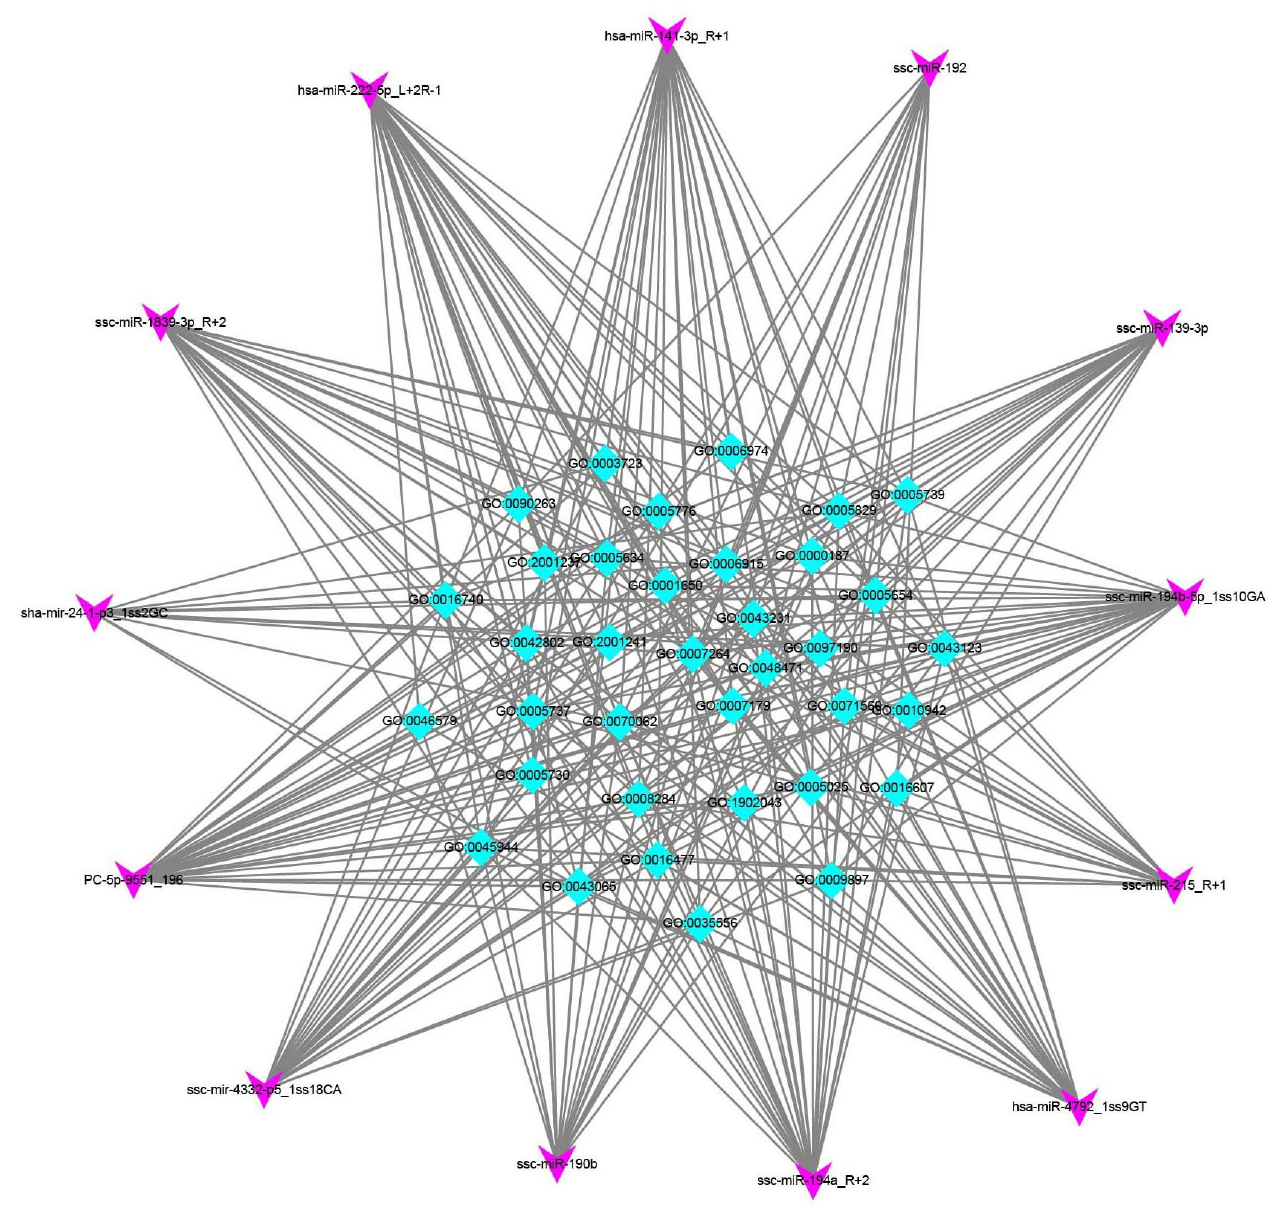
Figure 6. DEmiRNA – GO network analysis. The miRNA – GO network was built based on the relationship between significant biological functions and DEmiRNAs. The squares represent GOs affected by miRNAs, and the diamond nodes represent miRNA.